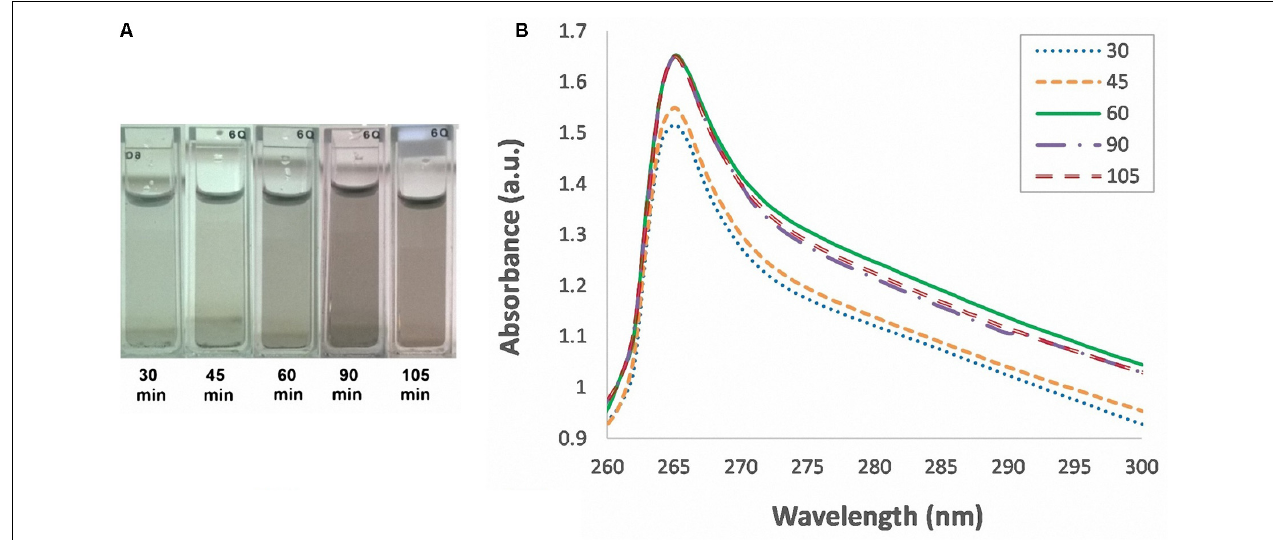
FIGURE 3 | (A) Dilute PAN/CNT/DMF solutions after ultrasonication at different times. (B) UV-visible spectrum of PAN/CNT/DMF solutions at different ultrasonication times.